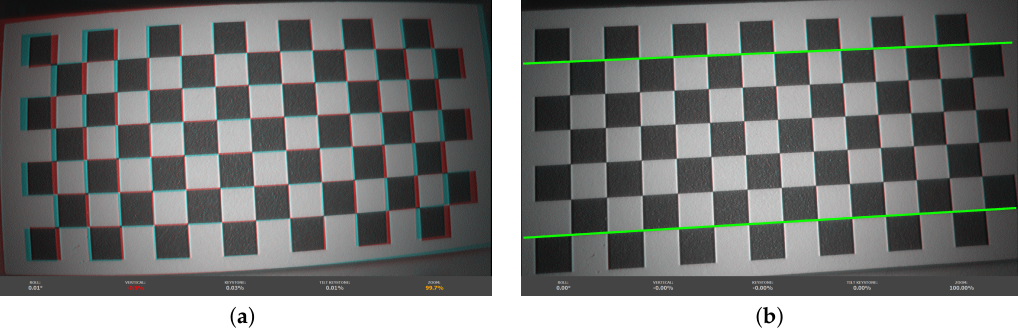
Figure 7. Stereo image pairs in anaglyph mode near the convergence plane showing error values before and after applying stereo lens distortion correction. ( a ) Distorted and non-rectified stereo image pairs. ( b ) Rectified stereo image pairs with eliminated lens distortion and correct visualization of straight